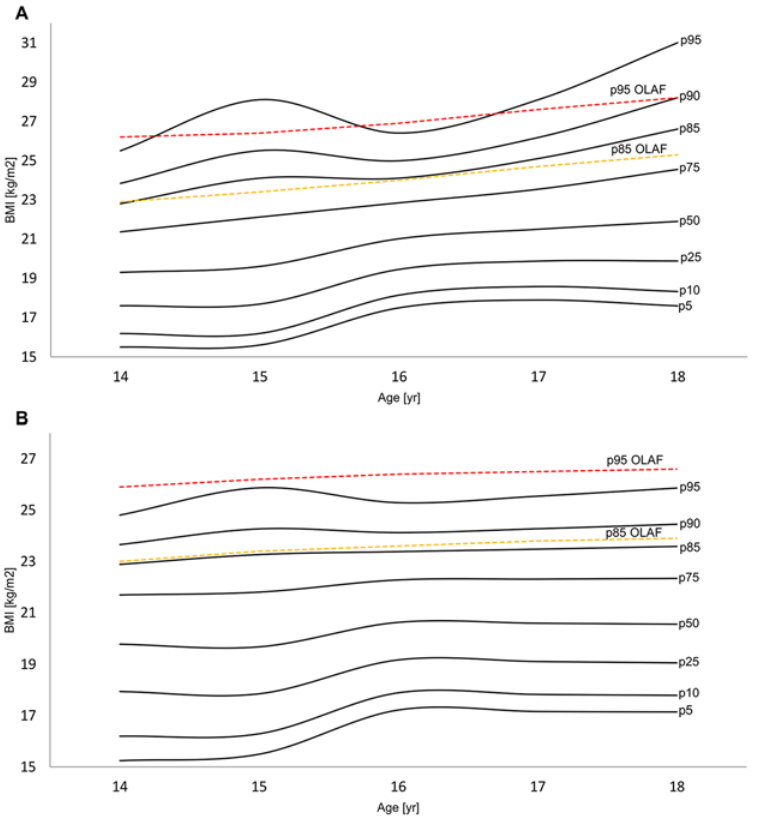
Fig 1. Smoothed percentiles of BMI for Polish adolescents with OLAF study [14] cutoffs (Polish children growth reference 2010). Boys (A), Girls (B).